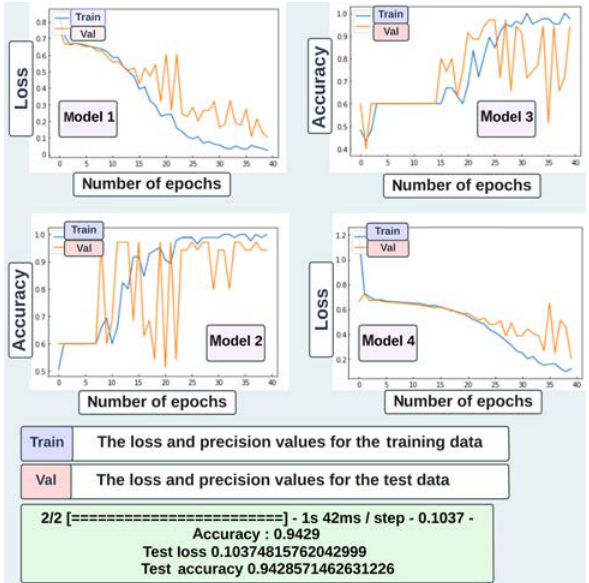
Fig. 15 Loss and accuracy for different models.